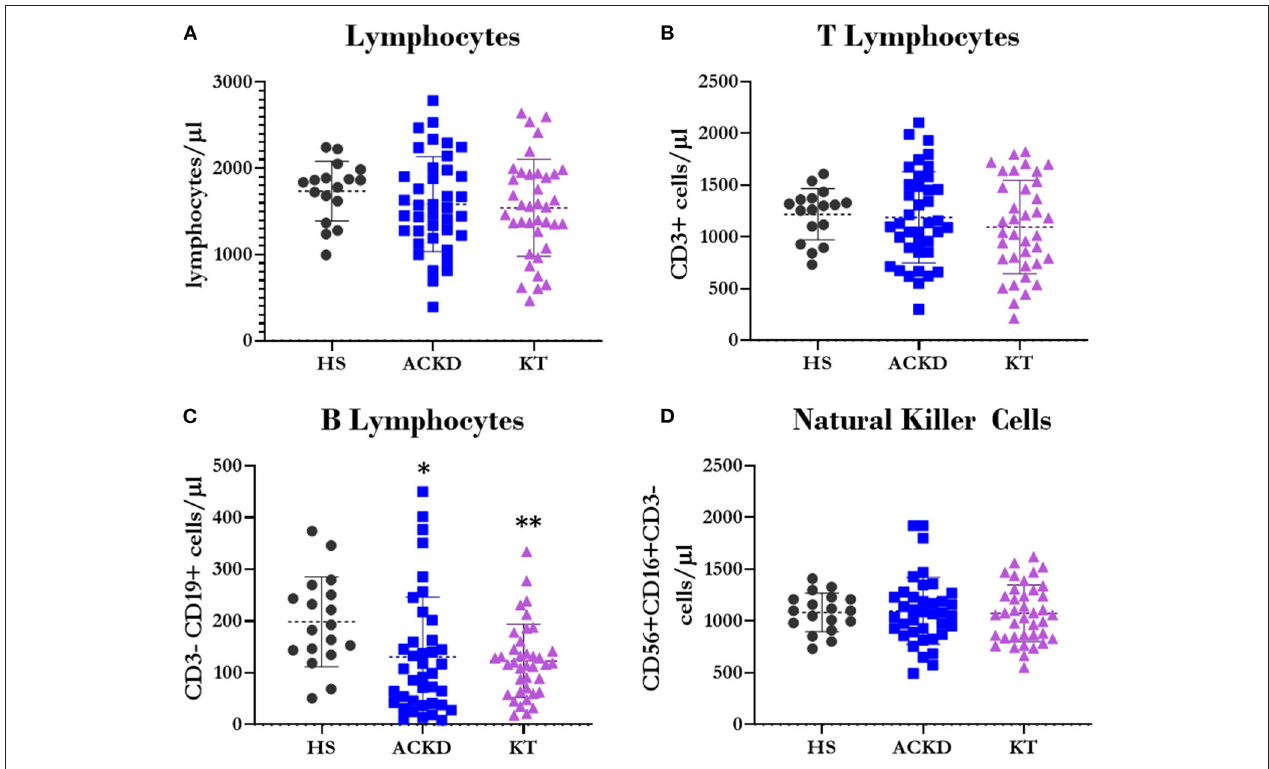
FIGURE 3 | Description of lymphocyte subpopulations. Number of total lymphocytes Ψ (A) , T lymphocytes Ω (B) (CD3 + ), B lymphocytes Ω (C) (CD3–CD19 + ), and natural killer cells Ψ (D) (CD56 + CD16 + CD3–) in healthy subjects (HS), patients with advanced chronic kidney disease (ACKD), and patients with kidney transplantation (KT). * p ≤ 0.05, ** p ≤ 0.01 vs. HS. Statistical analysis: Ψ ANOVA (Tukey test). Ω ANOVA (Games–Howell test). ANOVA, analysis of